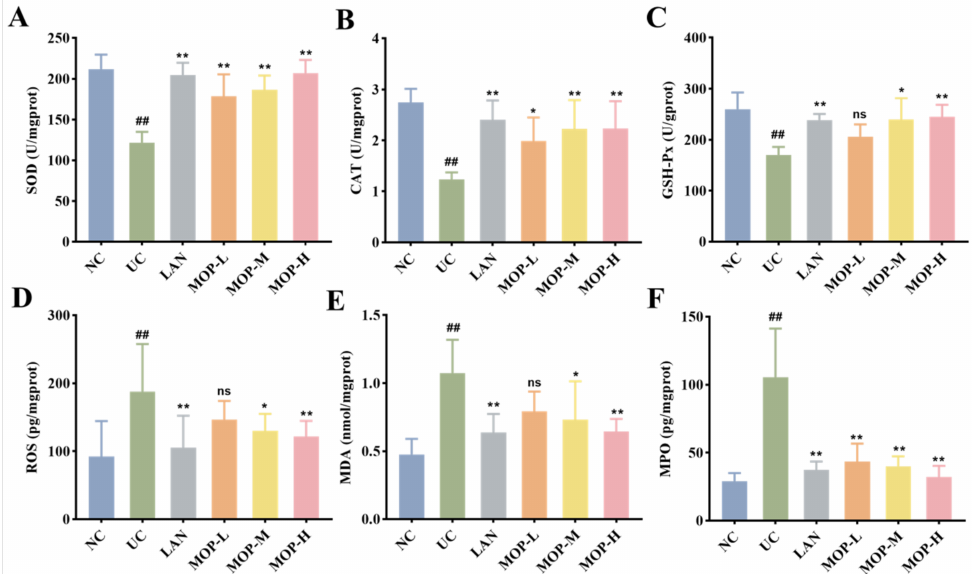
Figure 4. Effects of MOP on levels of SOD ( A ), CAT ( B ), GSH-Px ( C ), ROS ( D ), MDA ( E ), MPO ( F ) in stomach tissue of rats in vitro. # and * denotes significant differences (n = 6). ## p < 0.01 vs. NC group; * p < 0.05, ** p < 0.01 vs. UC group. ‘ns’ denotes no significant